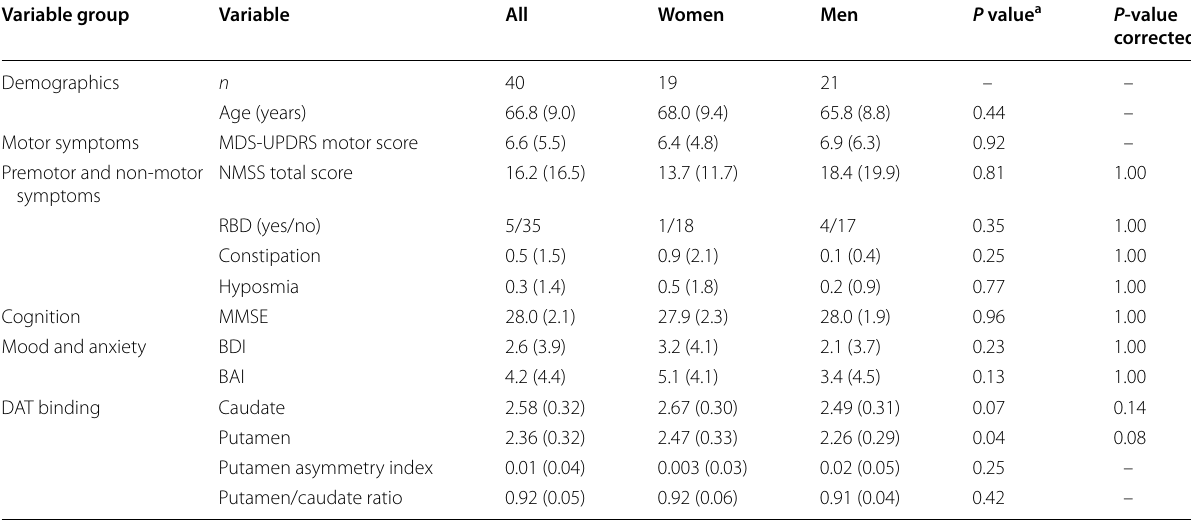
Values are means (SD) or n a Mann-Whitney U -test, independent-samples t -test or Fisher’s exact test b Bonferroni correction to adjust for multiple comparisons for two DAT binding regions and for eight symptom scales and questionnaires. Numbers of missing values: BAI 1 =